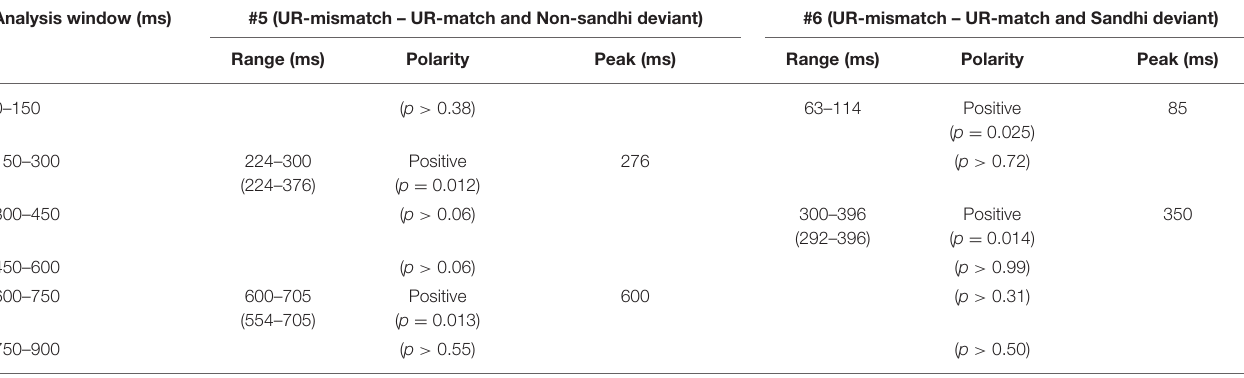
TABLE 5 | A summary of significant clusters found in the identity difference waves #5 and #6, examining the effect of UR Relation . Analysis window